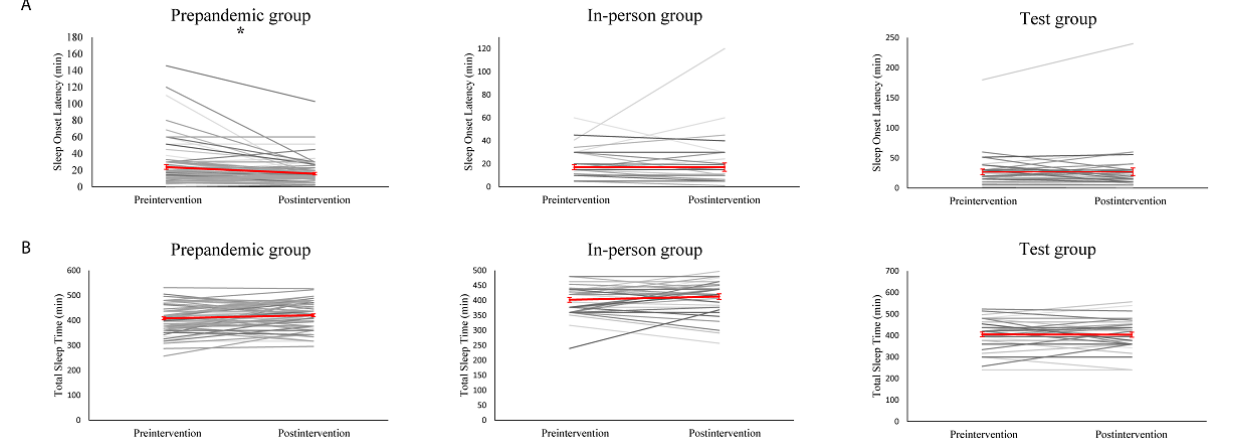
Figure 5. : Changes in sleep variables. Black lines depict change for individual participants, and red line indicates the mean change and standard errors in the group. (A) Sleep onset latency (SOL) decreases significantly on the control group, but not COVID1 or COVID2. (B) No significant changes were observed in total sleep time (TST). * P